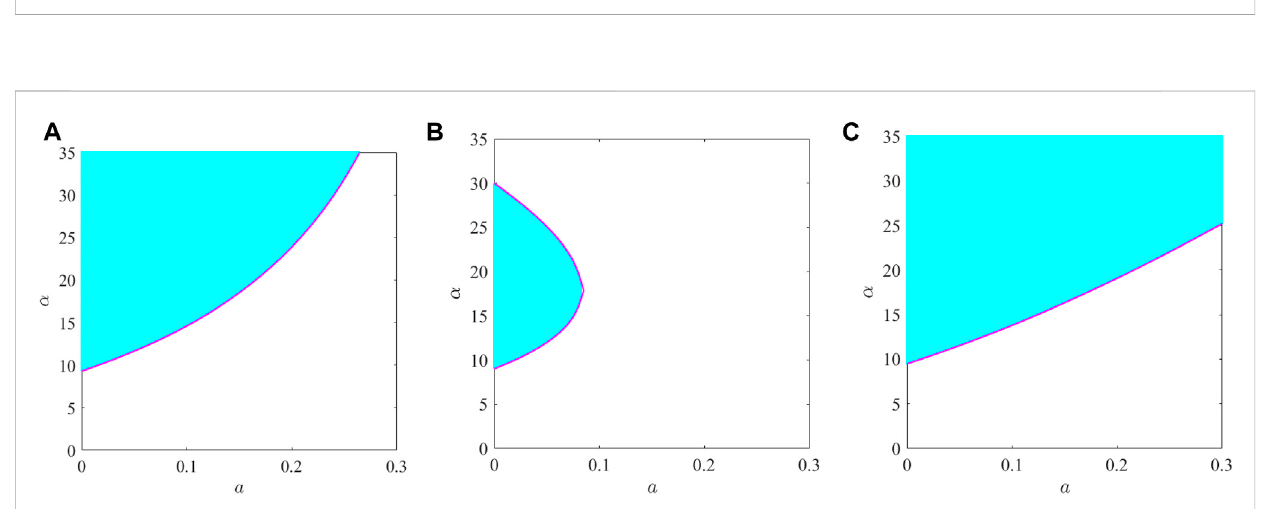
FIGURE 2 Synchronized regions of the uni fi ed chaotic system with varying dynamics parameter a and its boundary